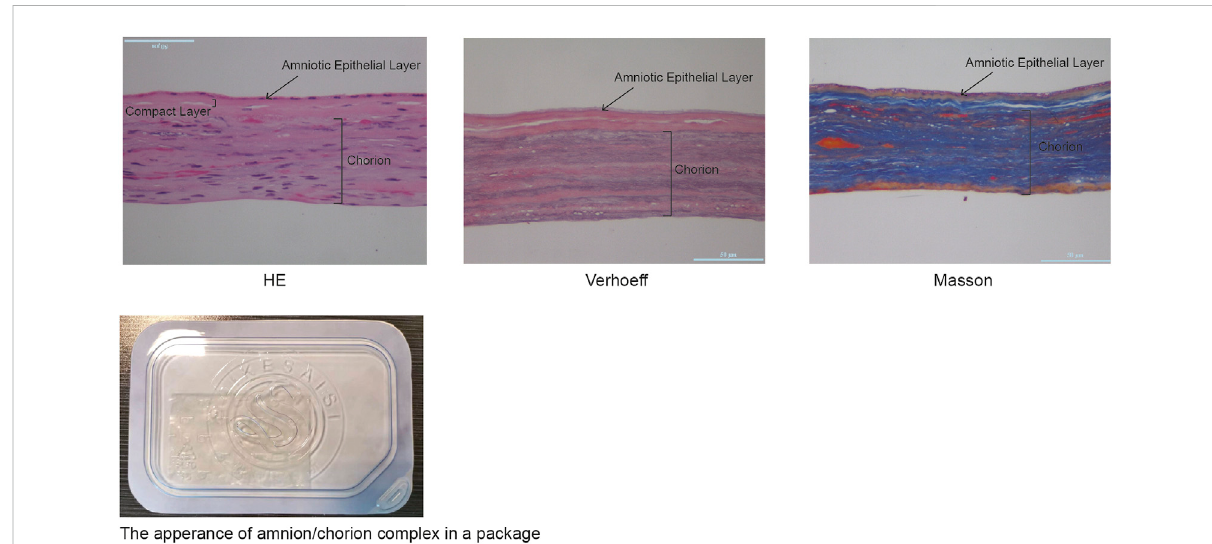
FIGURE 4 The histological analysis of the amnion/chorion complex. Histological analysis showed the amnion/chorion complex contained a multilayer